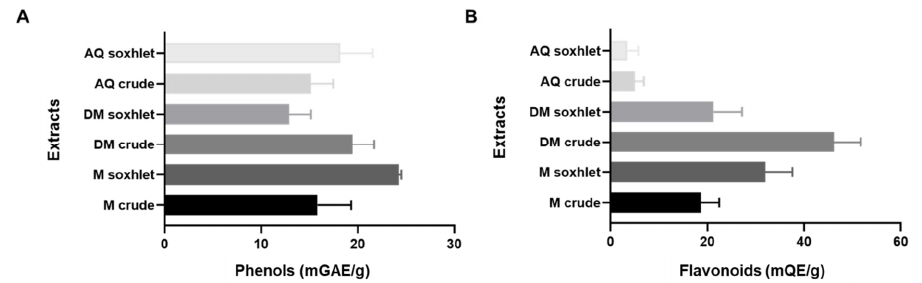
Figure 2. Total phenolic and flavonoid content of J. rubens various extracts. ( A ) The extract’s total phenolic content was determined by the Folin–Ciocalteu method and calculated as mg gallic acid equivalents GAE per gram of dry algal. ( B ) The extract’s total flavonoid content was measured by an aluminum chloride colorimetric assay and expressed as mg quercetin equivalent (QE) per gram of dried algal material. Values are reported as the mean ± SD ( n = 3). AQ: aqueous; DM;